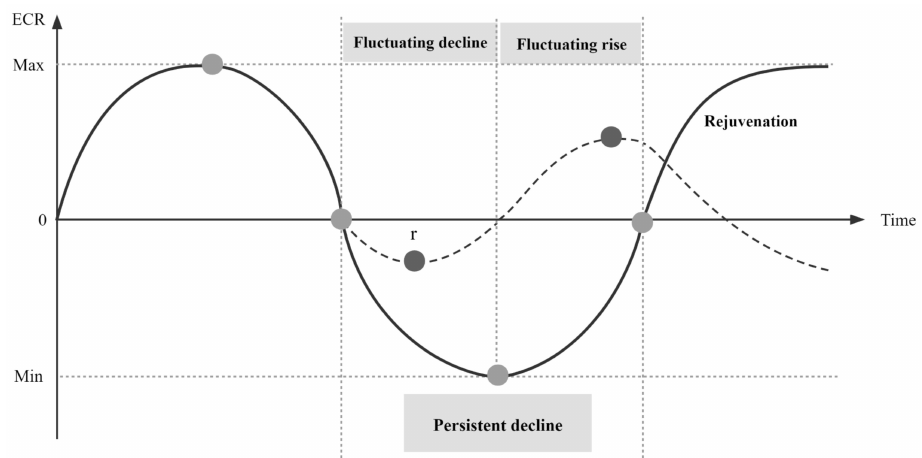
Figure 1. A model for tourism area life cycle measured by efficiency.